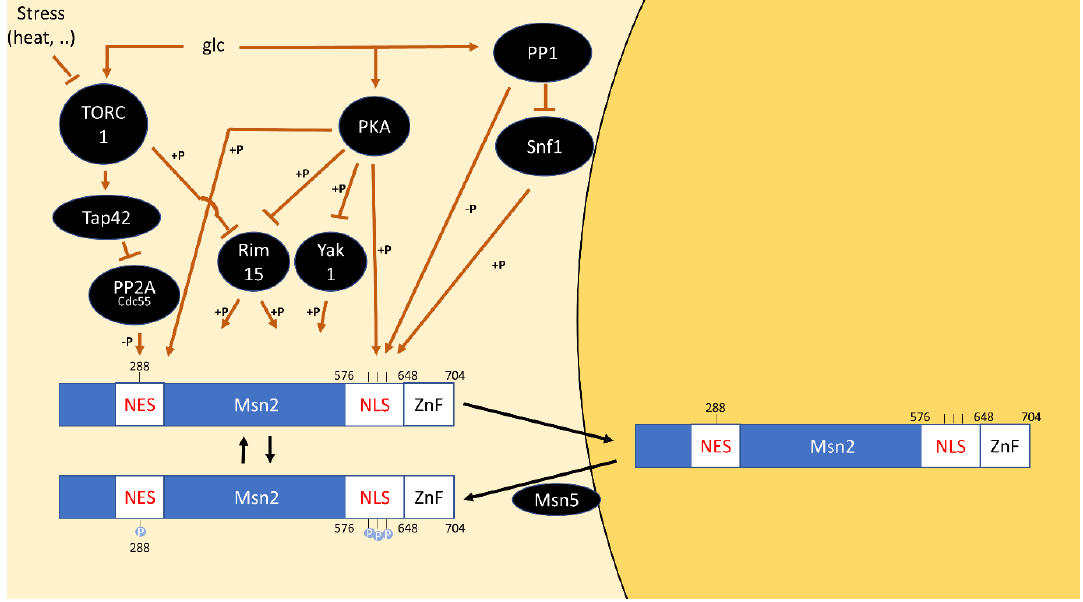
Figure 6. Model for the phospho-regulation of Msn2. Both the nuclear export signal (NES) and nuclear localization signal (NLS) are phosphorylated by PKA to promote Msn2 cytoplasmic localization. The NES is presumably dephosphorylated by PP2A Cdc55 upon TORC1 inactivation. The NLS is additionally phosphorylated by Snf1 and dephosphorylated by PP1. The localization of phosphorylation sites by Rim15 and Yak1 on Msn2 are unknown. Nuclear-cytoplasmic localization as a consequence of NES and NLS phosphorylation is shown, but the subcellular compartment in which phosphorylation events take place is unknown. A speculative additional dephosphorylation of an unknown site in the zinc-finger domain (ZnF) by PP2A Cdc55 is omitted.